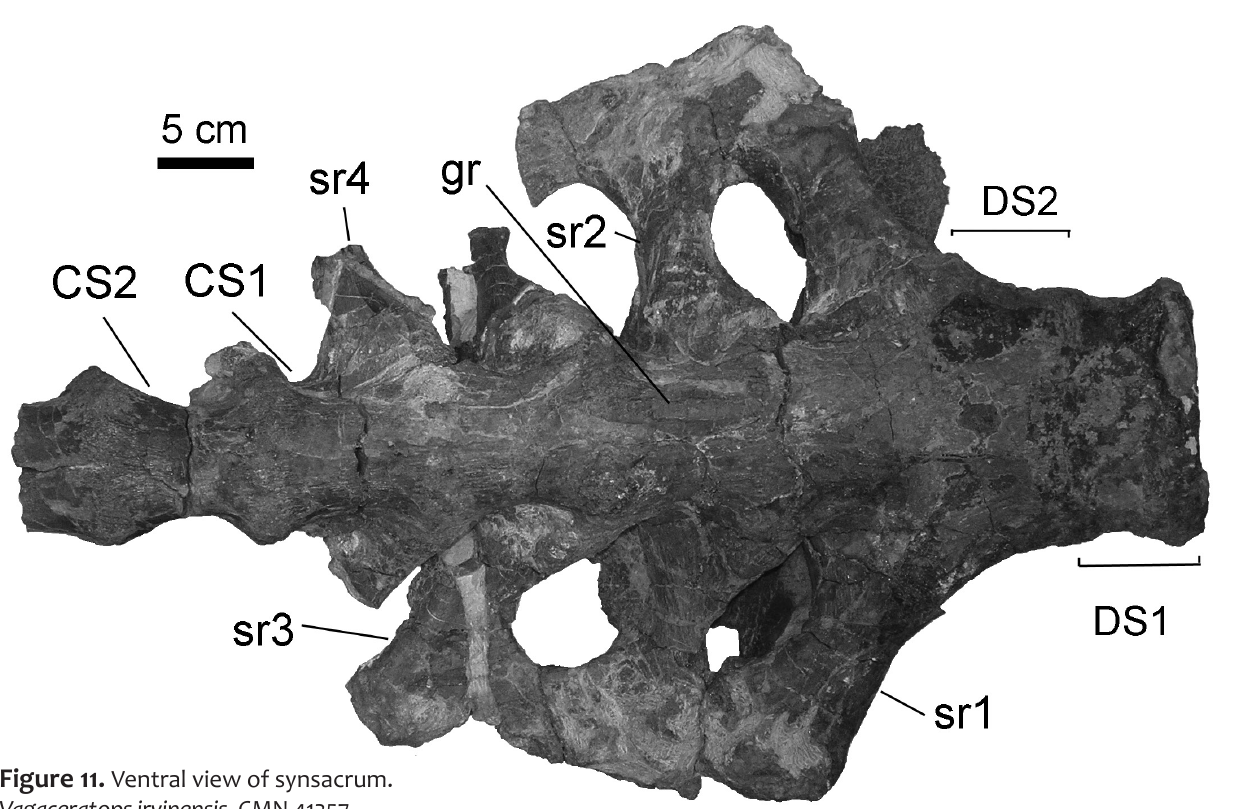
Figure 11. Ventral view of synsacrum. Vagaceratops irvinensis , CMN